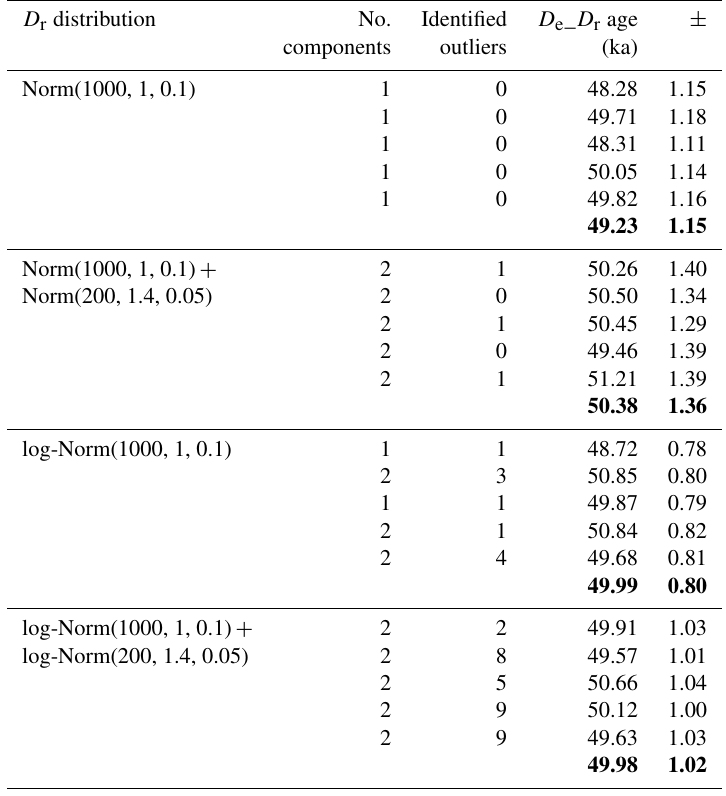
Table 1. Results of tests without added outliers. Tests were performed with four different shapes of D r distributions: Norm( n , m , SD) and log-Norm( n , m , SD) indicate normal and log-normal distributions, respectively, where ( n ) is the number of random values, ( m ) the mean of the distribution, and (SD) the standard deviation. The number of Gaussian components identified by the model when fitting the D r distribution is given, as is the number of points identified as outliers. Numbers in bold represent average values. D r distribution No. Identified D e _ D r age ± components outliers (ka) Norm(1000, 1, 0.1)